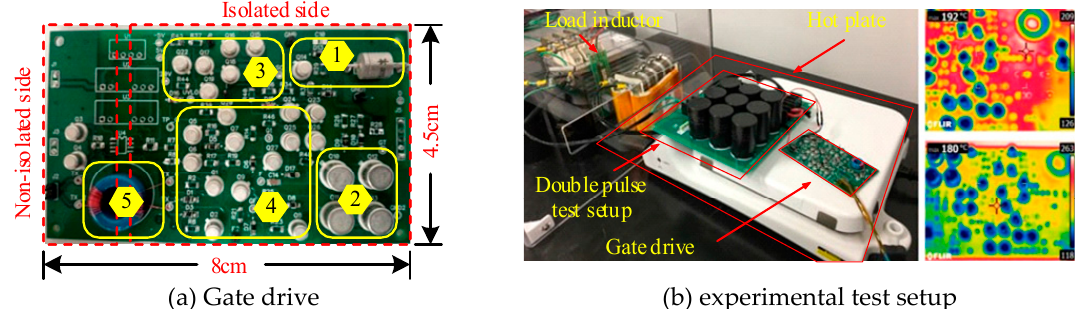
Figure 6. Developed high-temperature gate drive and the experimental setup